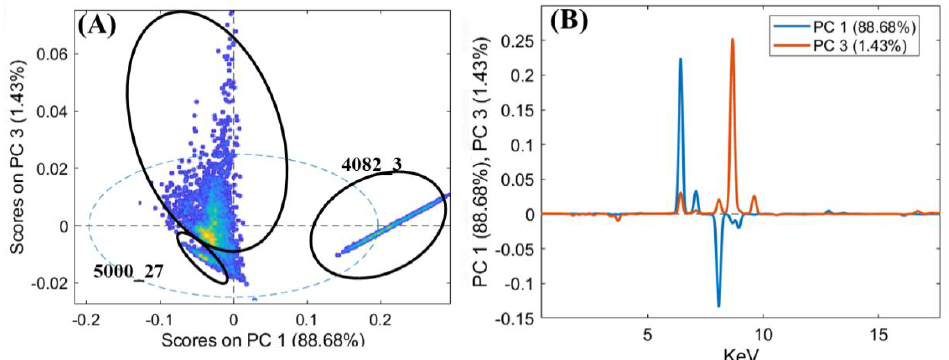
Figure 10. PCA score plot of the XRF spectra ( A ) and the loadings of PC1 and PC3 ( B ) for the fibulae (4003_7, 4025_4, 5000_27, and 5050_4), earrings (5079_5 and 5085_6), and ring (4082_3).